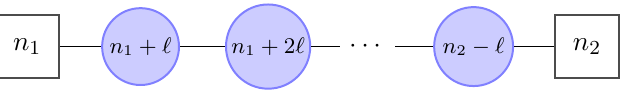
. Each edge connecting 1 ;n 2 is generically the same as that 1 ;n 2